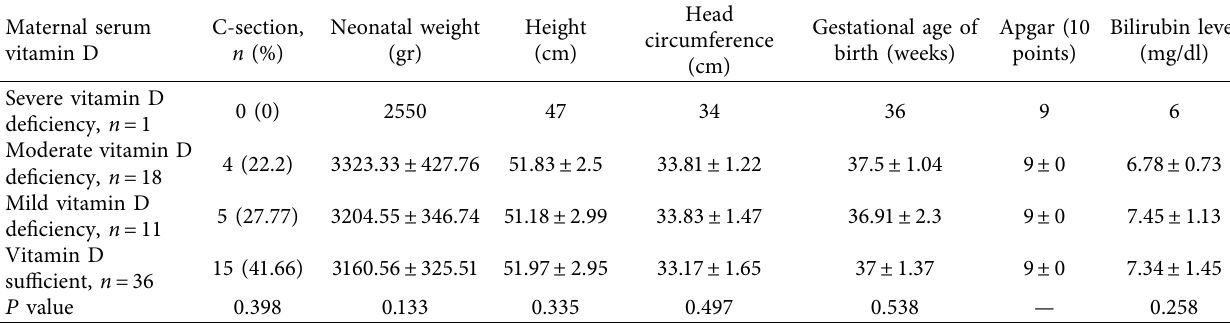
Table 3: Neonatal outcomes and maternal serum vitamin